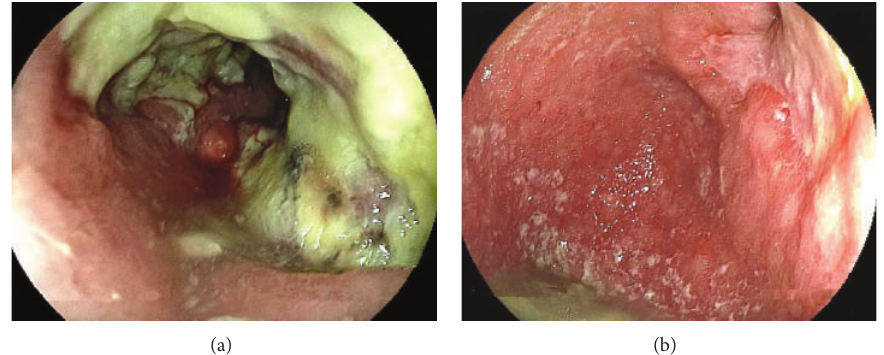
Figure 1: Upper gastrointestinal endoscopy. (a) Huge ulcerated tumor from the gastric angle to the antrum, extending to the duodenum, was seen before chemotherapy. (b) A remarkable reduction of tumor size was seen after the third course of chemotherapy.